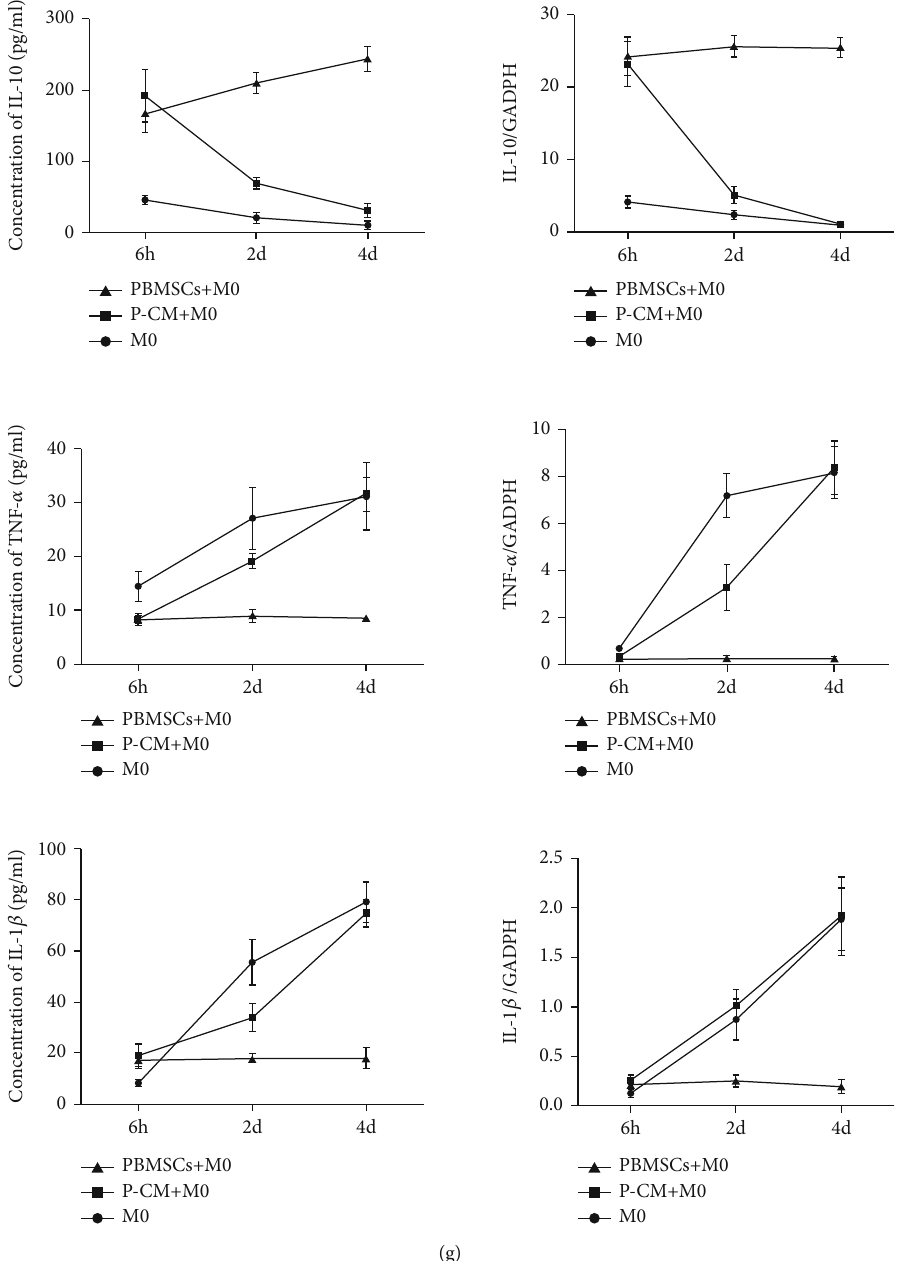
Figure 3: In fl uence of di ff erent coculture times on the secretion and expression of in fl ammatory cytokines by macrophages. (a, c, e) Concentrations of IL-10 (a), TNF- α (c), and IL-1 β (e) in the supernatant of each group were determined by ELISA at 6h, 2d, and 4 d. (b, d, f) The mRNA expression levels of IL-10 (b), TNF- α (d), and IL-1 β (f) from macrophages of the M0, P-CM+M0, and PBMSC+M0 groups were detected by RT-qPCR at 6 h, 2d, and 4d. (g) The secretion (left) and expression (right) of in fl ammatory cytokines at di ff erent time points for various culture groups. Graphs show the mean ± standarddeviation ; n = 3 ; ∗ P < 0 : 05, ∗∗ P < 0 : 01, and ∗∗∗ P < 0 : 001 . ELISA: enzyme-linked immunosorbent assay; GAPDH: glyceraldehyde 3-phosphate dehydrogenase; IL: interleukin; M-CM: Roswell Park Memorial Institute-1640 media with 10% fetal bovine serum and 20% L929 conditioned media; P-CM: PBMSC- conditioned media; PBMSCs: peripheral blood-derived mesenchymal stem cells; RT-qPCR: real-time quantitative polymerase chain reaction; TNF: tumor necrosis